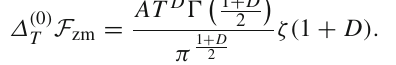
This integral can be computed in terms of more compli- cated combinations of polylogarithms of higher order.